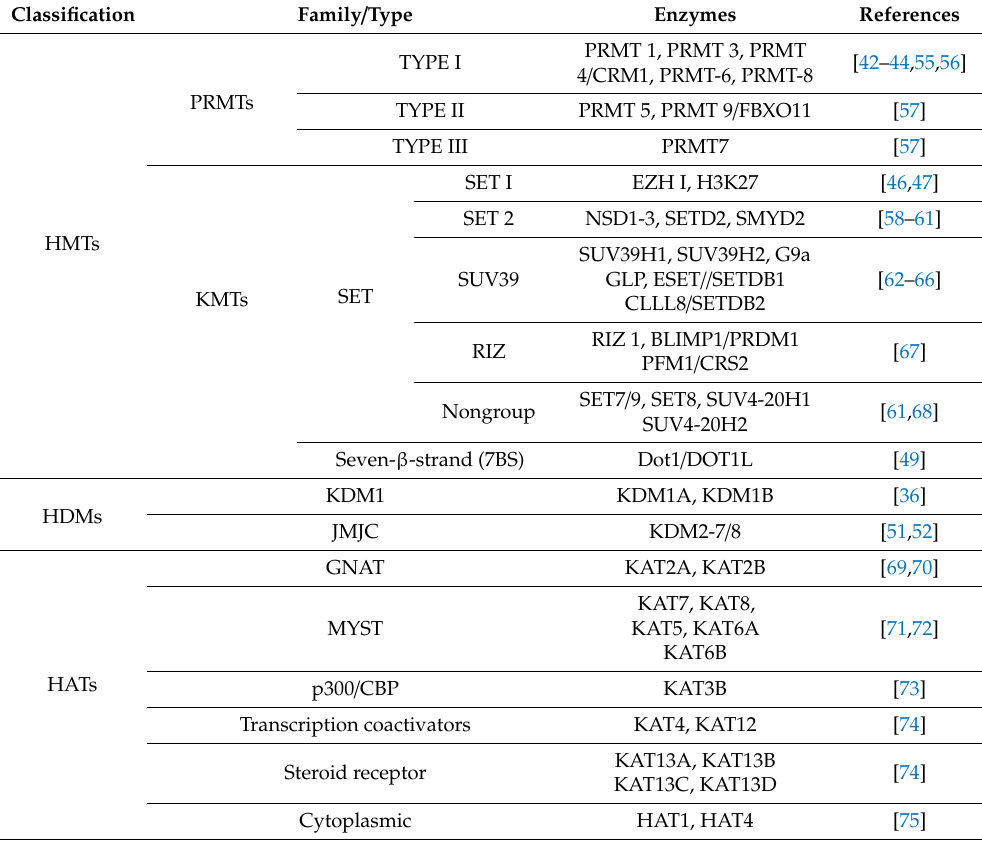
Figure 2. Chemical reactions involved in histone methylation reaction. Table 1. Various classes / families / subtypes of enzymes involved in histone methylation and acetylation